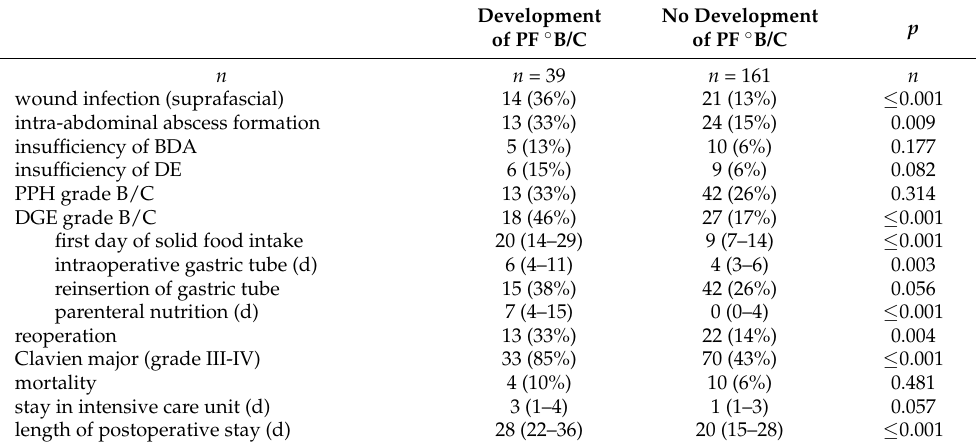
Table 2. Clinically relevant PF ◦ B/C—postoperative outcome/complications.